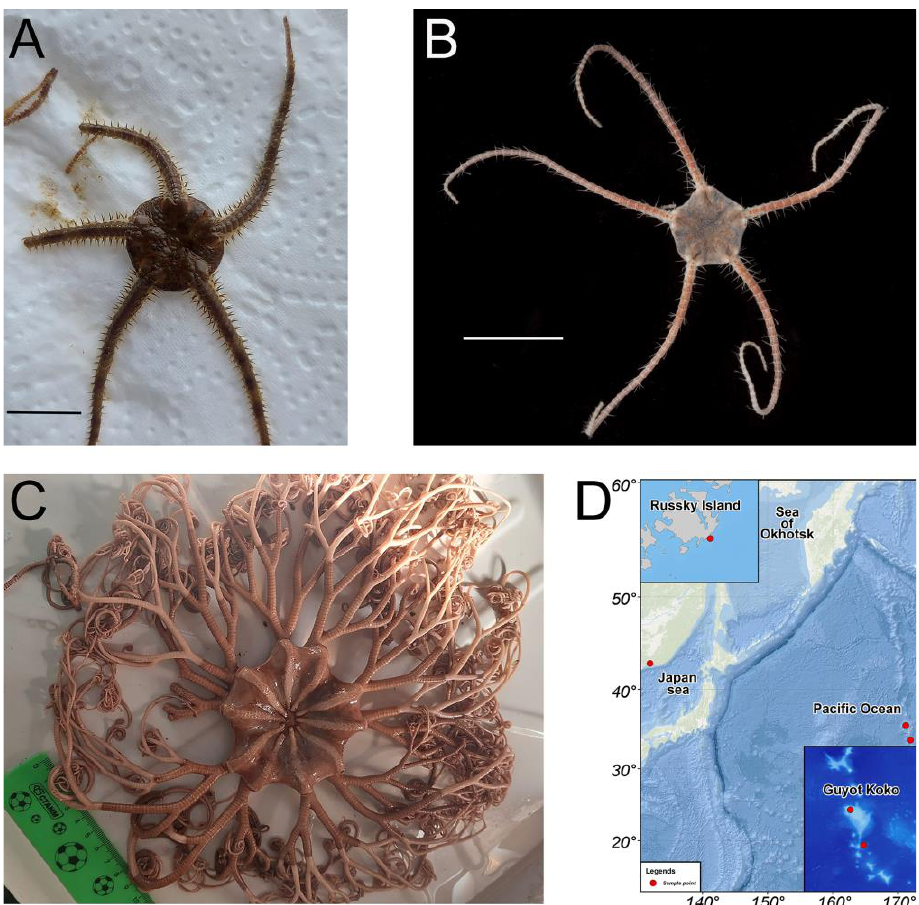
Figure 1. ( A , B ) Brittle stars Ophiura sarsii ( A ) and Ophiura ooplax ( B ). Scale bars: 1 cm. ( C ) Basket star Gorgonocephalus cf. eucnemis . ( D ) Map depicting the sample collection locations: Russky Island in the Japan sea for O. sarsii , Guyot Koko in the Pacific Ocean for O. ooplax, and G. cf. eucnemis .